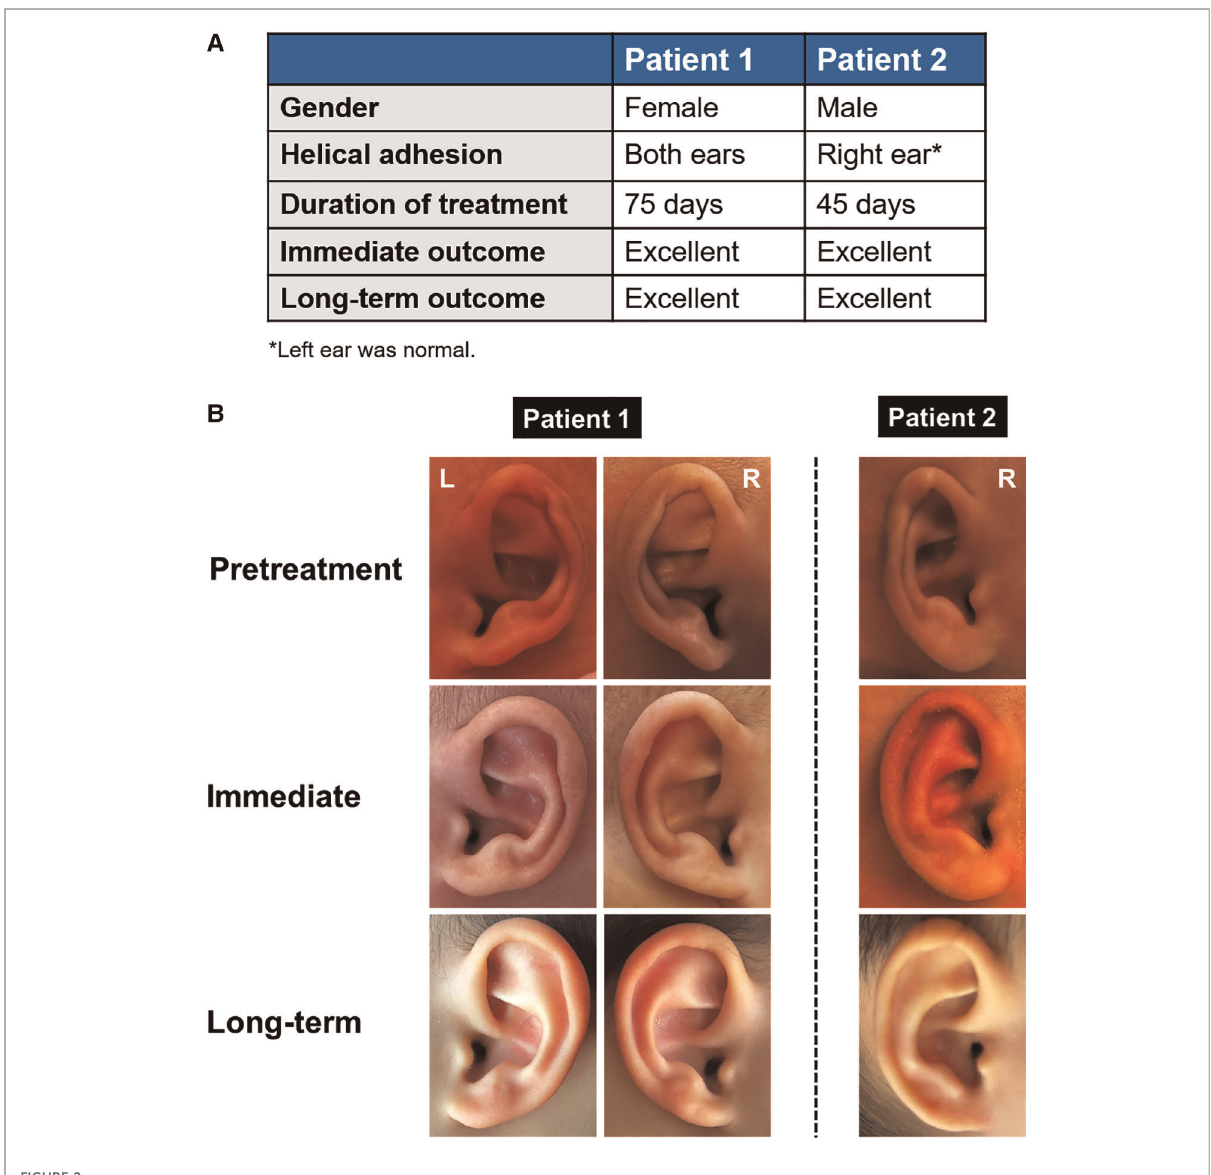
FIGURE 2 One dizygotic twin pair with helix